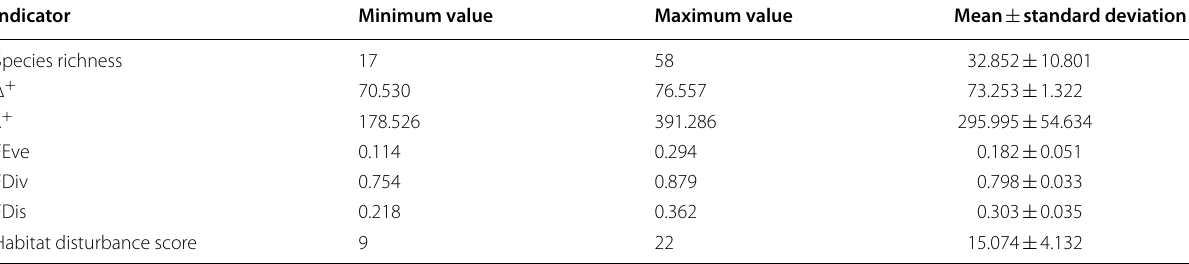
Table 1 Minimum value, maximum value and mean standard deviation of species richness, index of taxonomic distinctness (Δ + ), ± index of variation in taxonomic distinctness (λ + ), functional evenness (FEve), functional divergence (FDiv), functional dispersion (FDis) of the spider community and habitat disturbance score of the 27 sites studied along the Ganga River